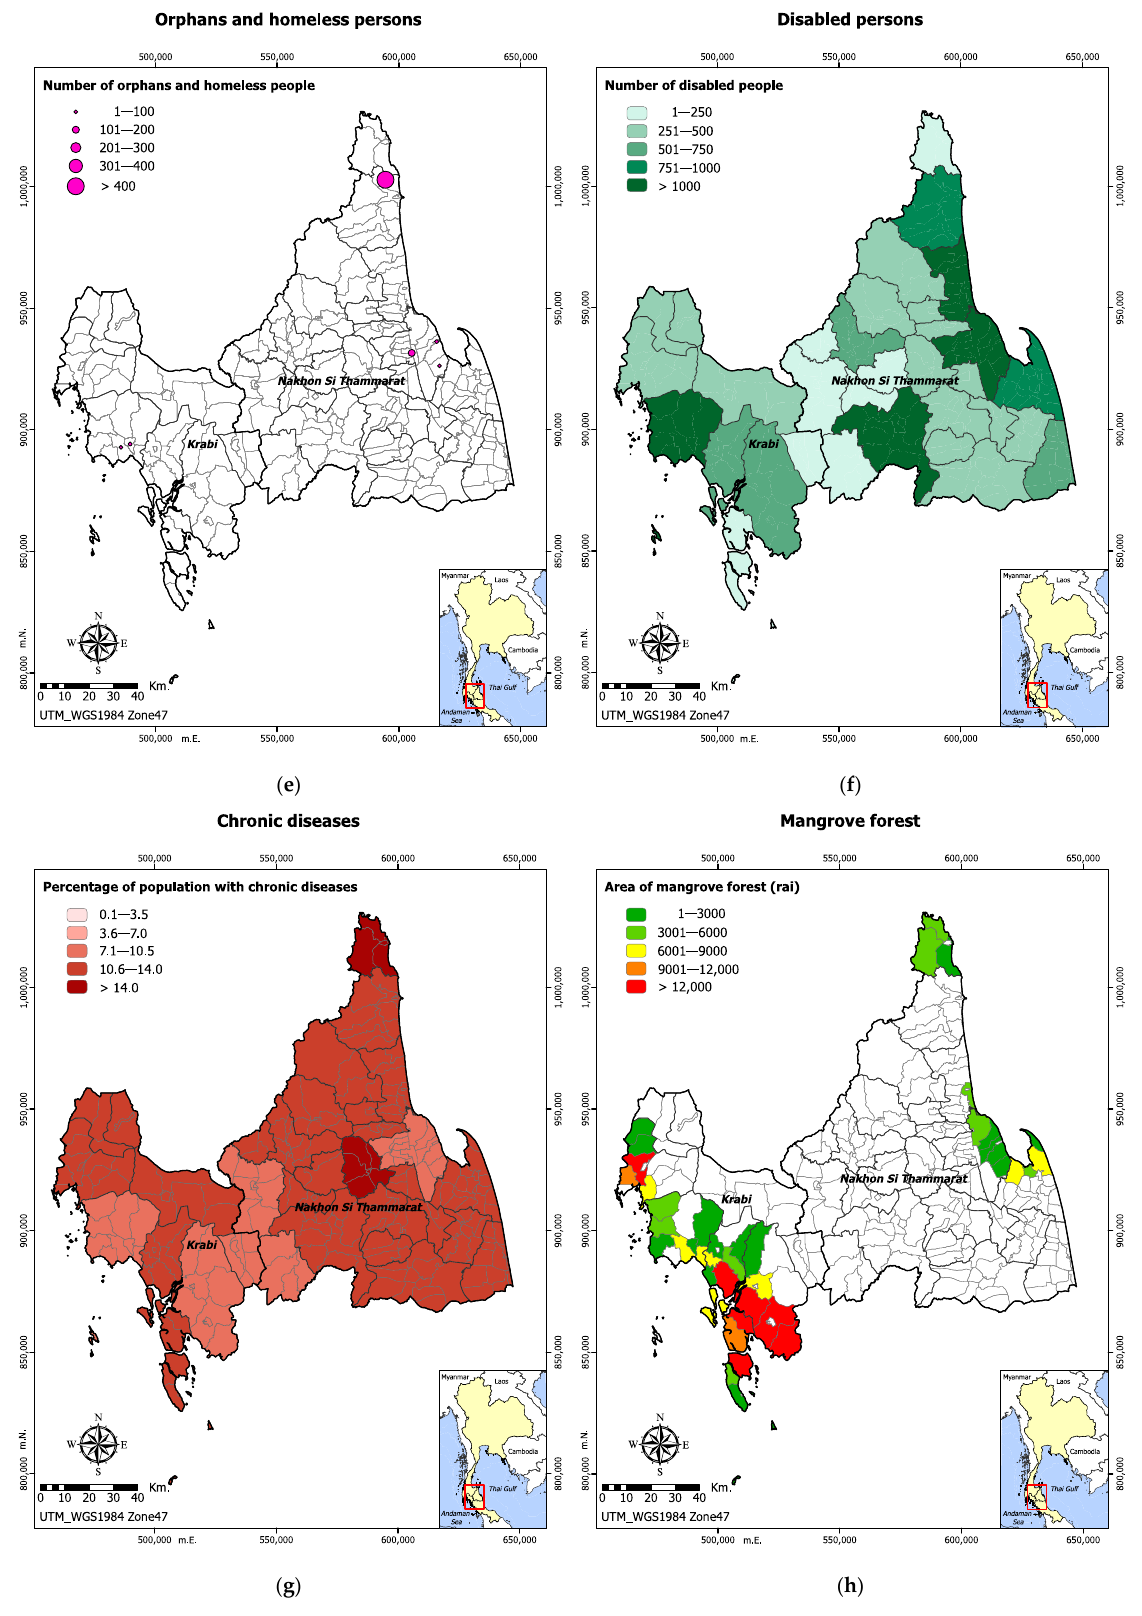
Figure 3. Vulnerability to natural hazards: ( a ) proportion of infants; ( b ) proportion of children under the age of five; ( c ) proportion of population aged 60 years and over; ( d ) number of prisoners; ( e ) number of orphans and homeless people; ( f ) number of disabled persons; ( g ) proportion of popula- tion with chronic diseases; ( h ) area of mangrove forest. Not all subdistricts have prisons, but, overall, there were more prisoners in Nakhon Si Thammarat than in Krabi, as shown in Figure 3d. Numbers of orphans and homeless people were very small in both provinces. Only one subdistrict in Nakhon Si Thammarat had more than 400 orphans and homeless people, as shown in Figure 3e. All subdistricts in both provinces had disabled persons. Only one district (Mueang Krabi) in Krabi com- pared to three districts (Tha Sala, Mueang Nakhon Si Thammarat, and Thung Song) in Nakhon Si Thammarat had at least 750 persons living with disabilities as shown in Figure 3f. Chronic diseases were prevalent in both provinces. Most subdistricts in both Krabi and Nakhon Si Thammarat provinces had more than 7% of their population living with a par- ticular chronic ailment as shown in Figure 3g. Between the two provinces, Krabi had the largest area and the greatest number of districts covered by mangrove forests as shown in Figure 3h. 3.2. Resilience to Disasters Based on data collected, variables of exposure, vulnerability, soft coping capacity, and hard coping capacities were developed in a scale in each of 61 (48 subdistricts, 12 subdistrict municipalities, 1 town municipality) and 184 (131 subdistricts, 49 subdistrict